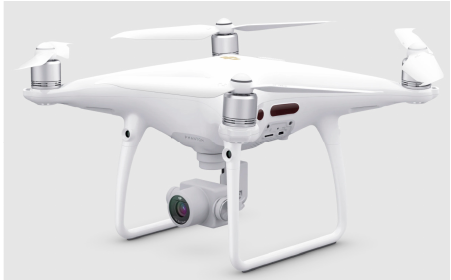
Figure 3. DJI Phantom 4 Pro UAV.